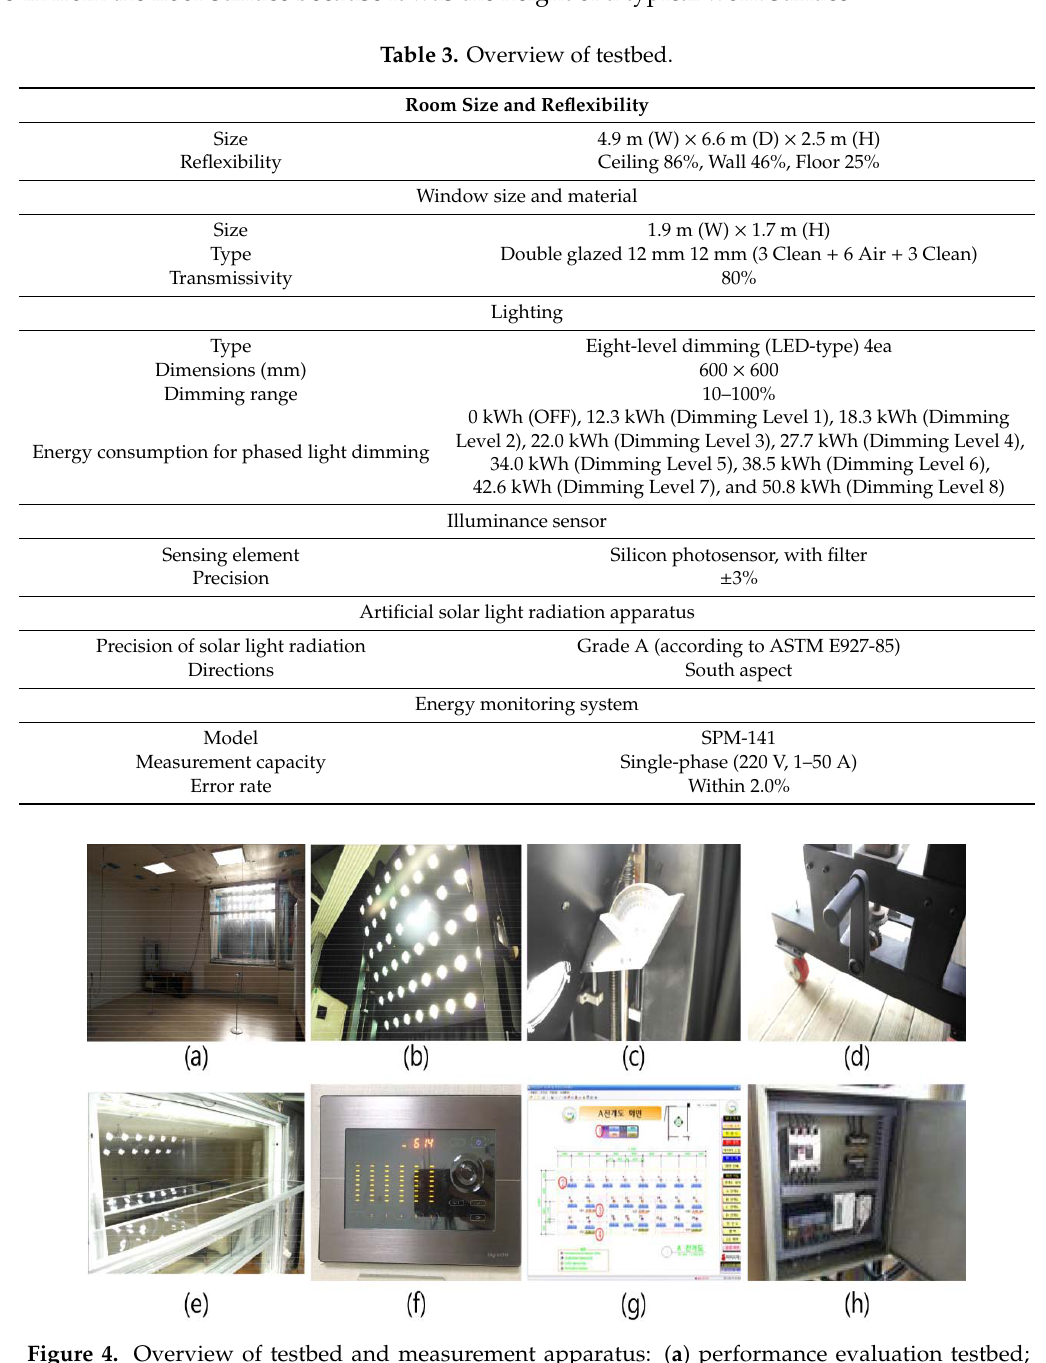
Figure 4. Overview of testbed and measurement apparatus: ( a ) performance evaluation testbed; ( b ) artificial solar irradiation apparatus; ( c ) control of light source angle of artificial solar irradiation apparatus; ( d ) lever to control light source altitude of artificial solar irradiation apparatus; ( e ) installed light shelf; ( f ) eight-level lighting controller; ( g ) illuminance sensor monitoring server; ( h ) energy monitoring system.